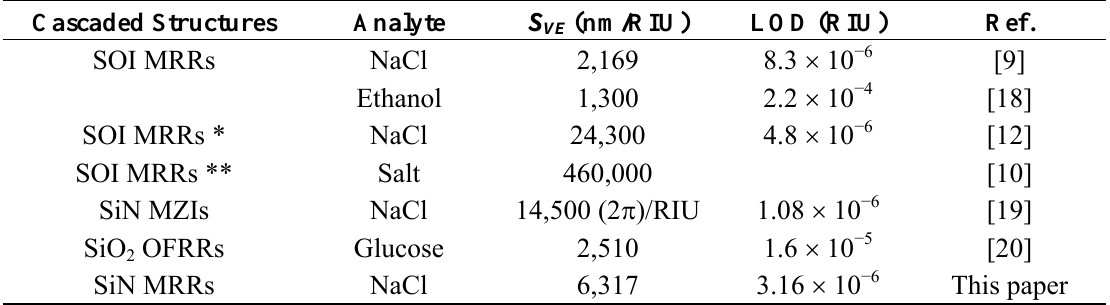
Table 1. Cascaded optical structures based on the Vernier effect for sensing applications. Cascaded